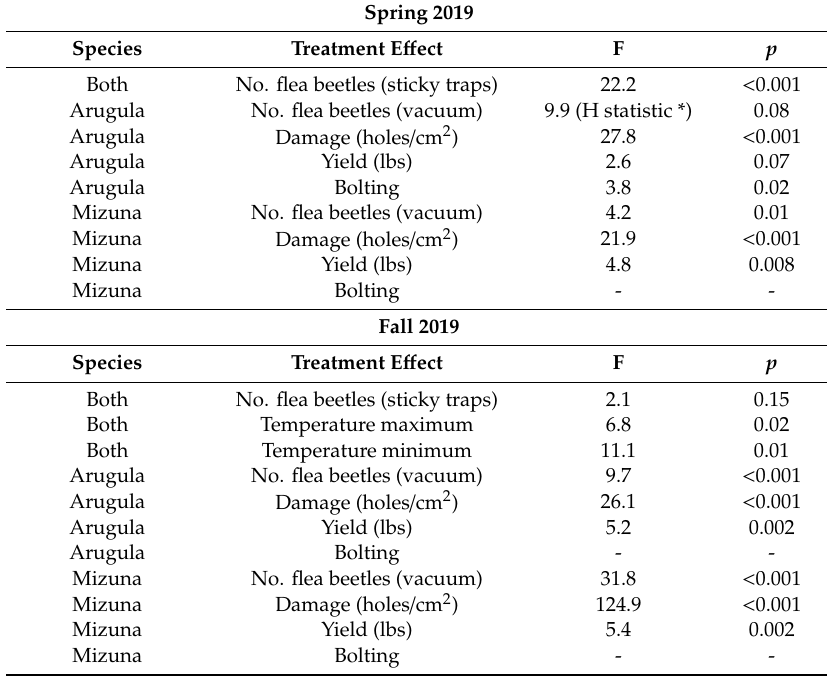
Table 5. Statistical analysis of e ff ect of treatment on number of flea beetles found, flea beetles damage per unit leaf area, crop yield, and the number of stems